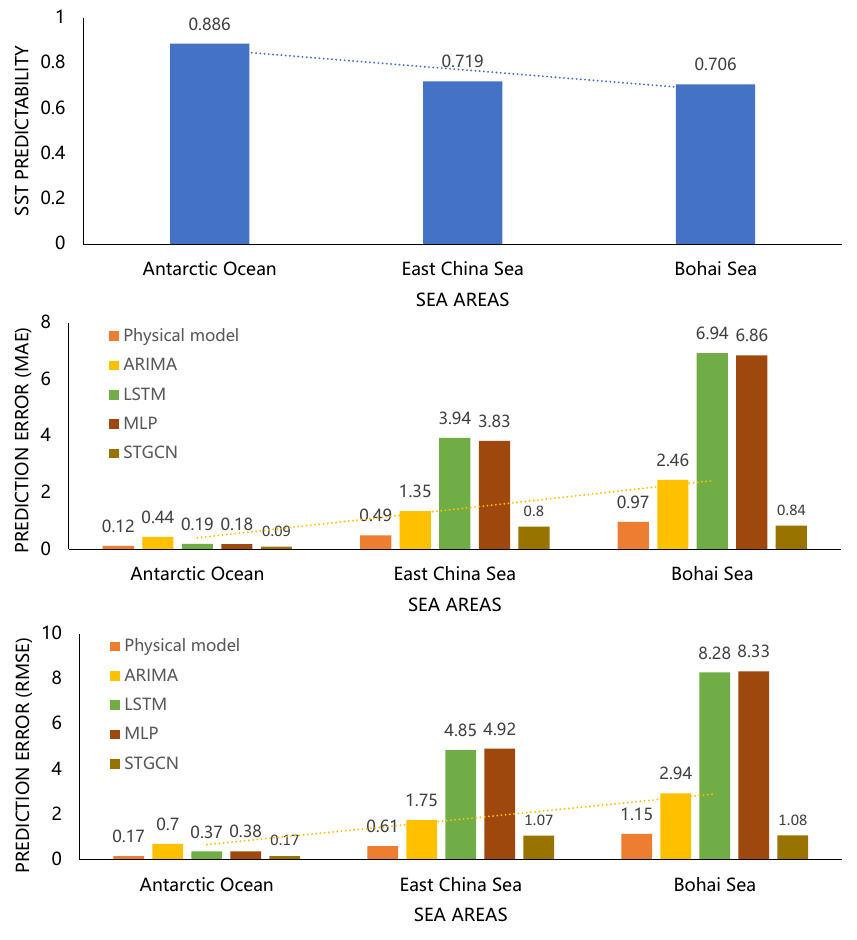
Figure 13. The SST predictability and prediction error(MAE and RMSE) in three sea areas of five pre- diction models. The SST predictability for each sea area is the average value of the SST predictability of all grid regions. The relationship between SST predictability and prediction error is the opposite, con- firming the effectiveness of the predictability evaluation method. The physical model is Copernicus Marine global analysis and forecast product